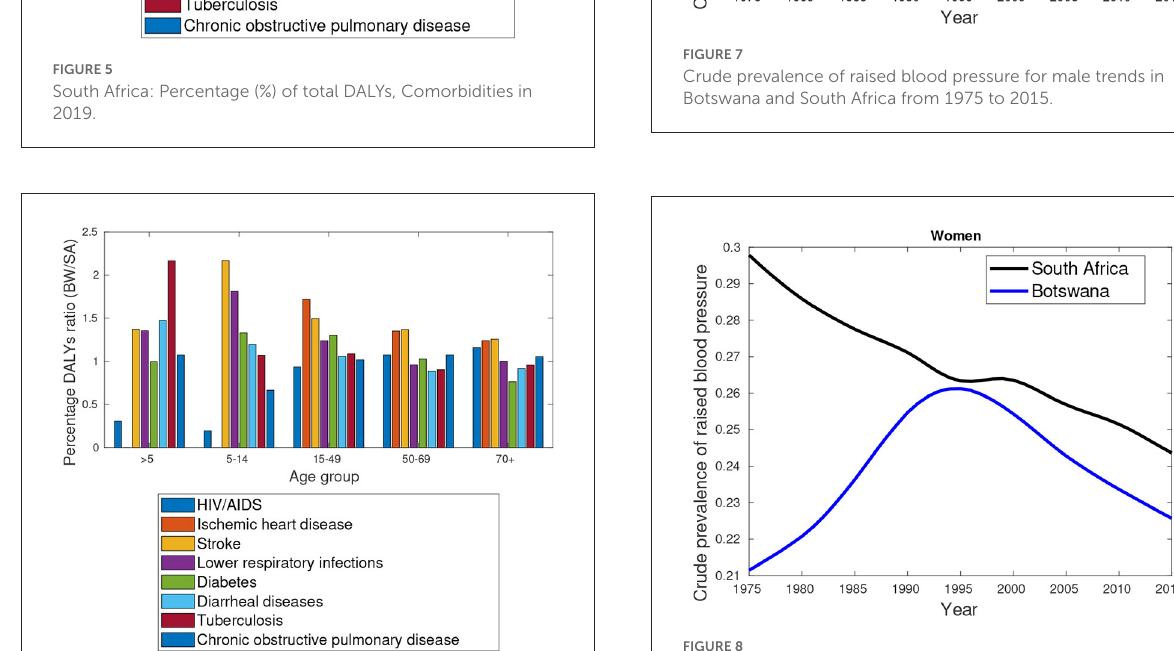
FIGURE6 Botswana South Africa: Percentage DALYs ratio, Comorbidities in 2019.